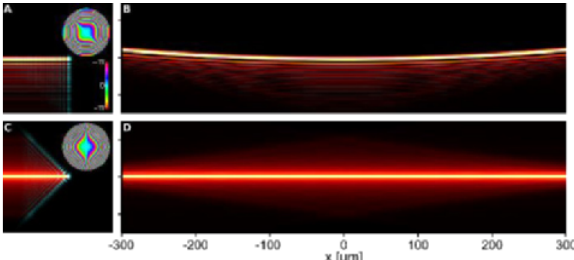
Fig. 1. Scanning an Airy beam to form a virtual light sheet as a curved surface (A-B), or planar illumination (C-D). Adapted from Hosny et al. [9] (CC BY 4.0).